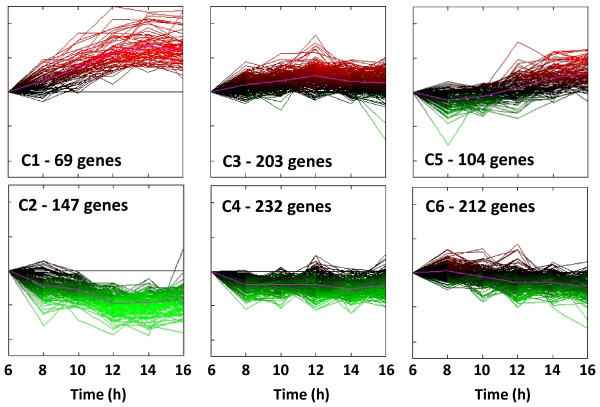
Temporal expression-based clustering of genes differentially expressed during cellulose fermentation. K-means clustering of genes that were differentially expressed in time-course analysis of transcript level changes during Avicel® fermentation by Clostridium thermocellum ATCC 27405. Total of 967 genes (excluding 321 genes encoding hypothetical and proteins of unknown function) were clustered into 6 bins based on Euclidean distance using the TIGR MeV® 4.0 software.